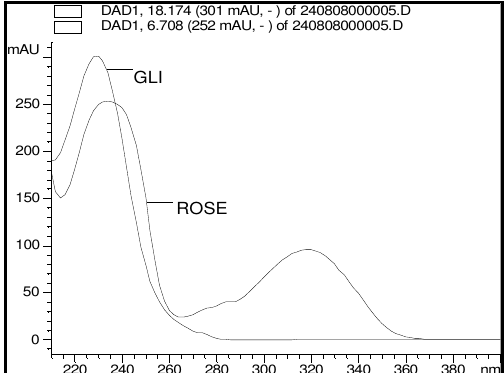
Figure 1. Typical HPLC chromatogram of GLI, ROSE and PIO Chromatogram showing well resolved peaks of GLI, ROSE and PIO